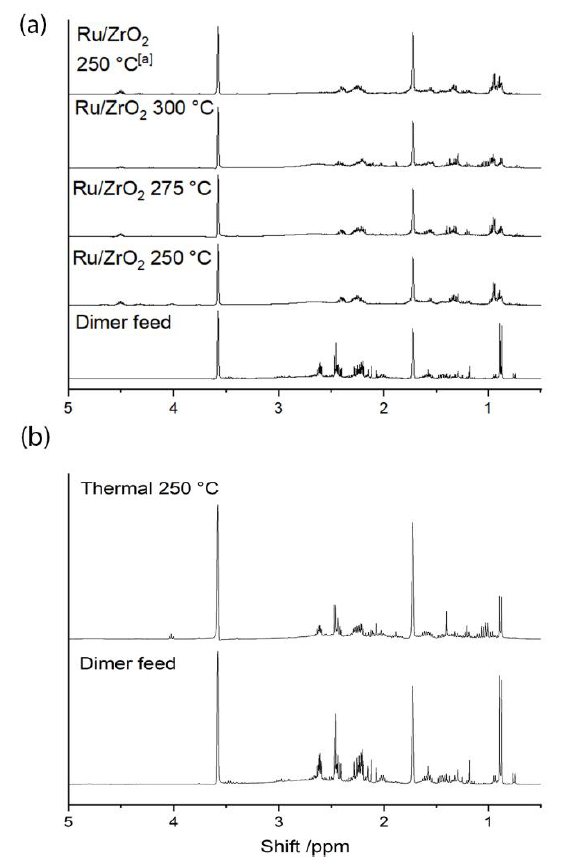
Figure 9. 1 H nuclear magnetic resonance (NMR) spectra (0.5–5.0 ppm) of the feed and the products obtained with ( a ) Ru/ZrO 2 catalyst and ( b ) thermally at various reaction temperatures. [a] τ b = 1.1 g cat g feed−1 h.